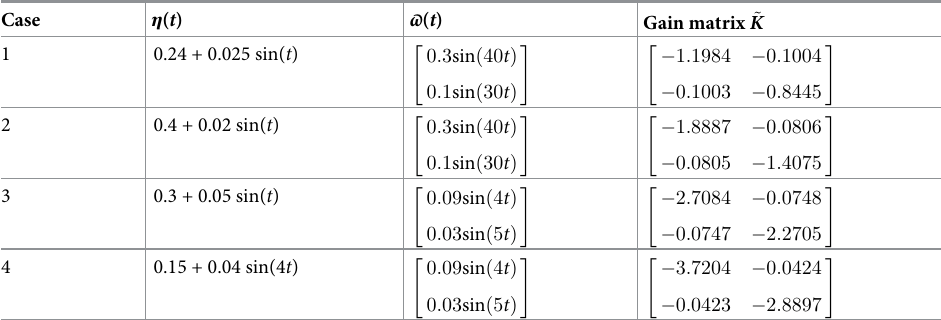
Table 1. Gain matrix ~ K for distinct delay and disturbance